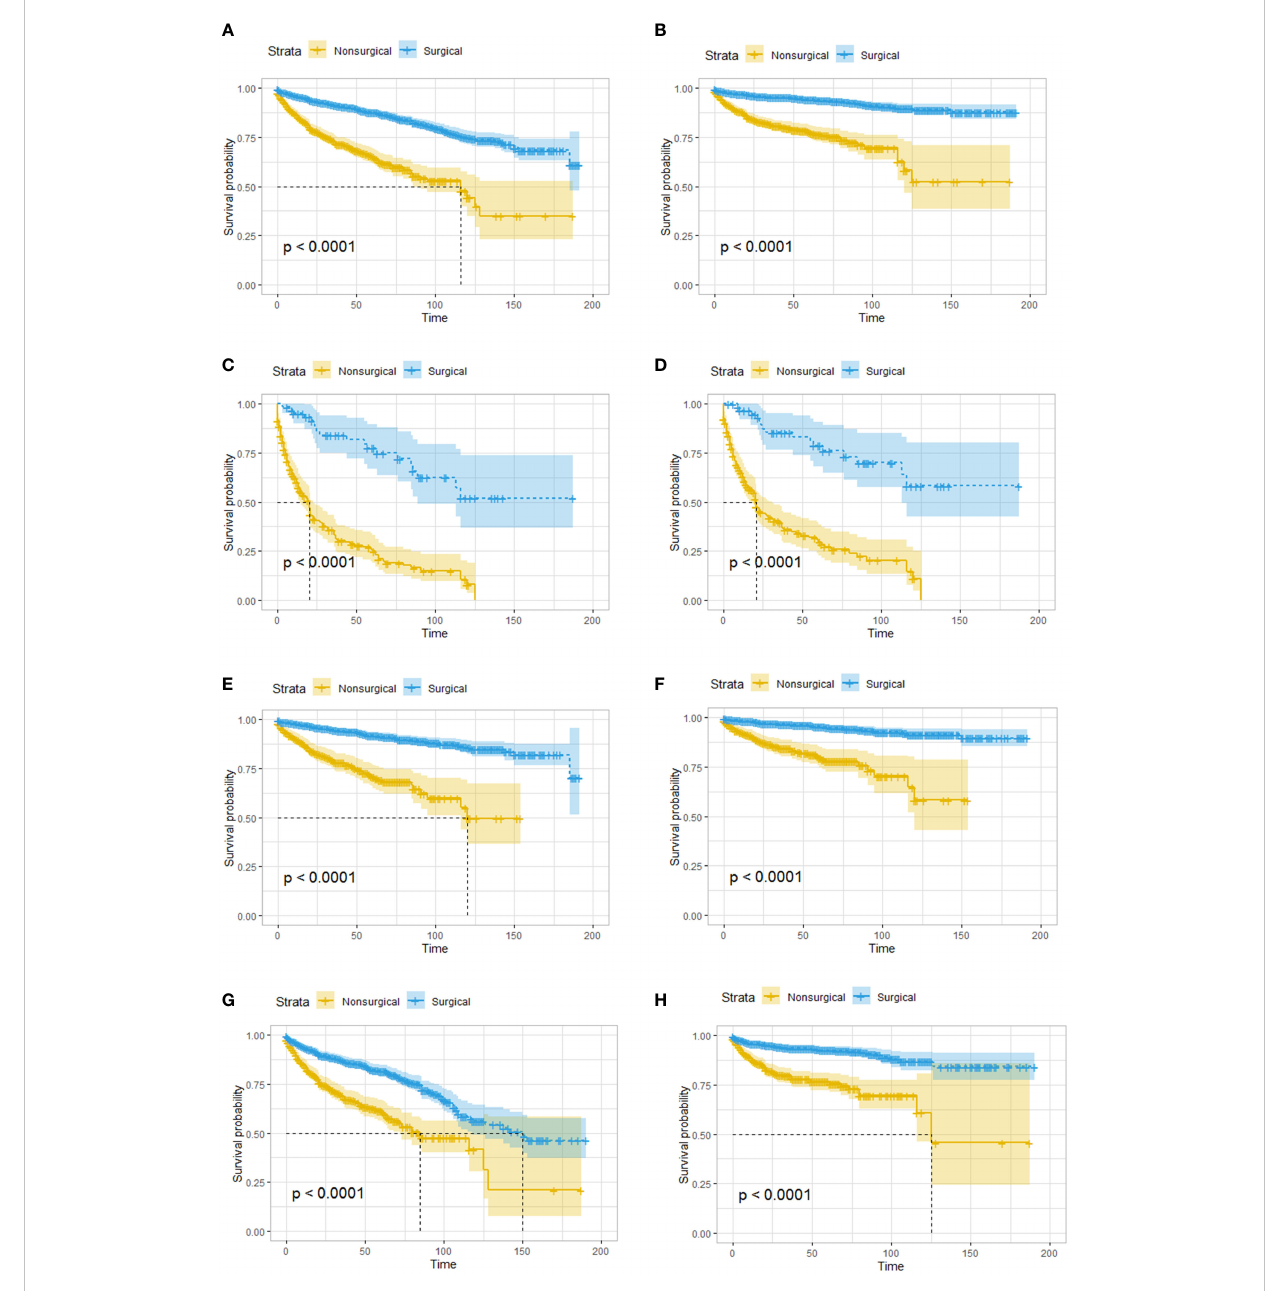
FIGURE 1 Survival analysis based on surgery: patients in the surgical group had better OS and CSS, regardless of age and tumor metastasis. OS (A) and CSS (B) of all the patients. OS (C) and CSS (D) of patients with distant metastatic tumor. OS (E) and CSS (F) of patients younger than 65 years old. OS (G) and CSS (H) of patients greater than or equal 65 years old. OS, overall survival; CSS, cancer-speci fi c